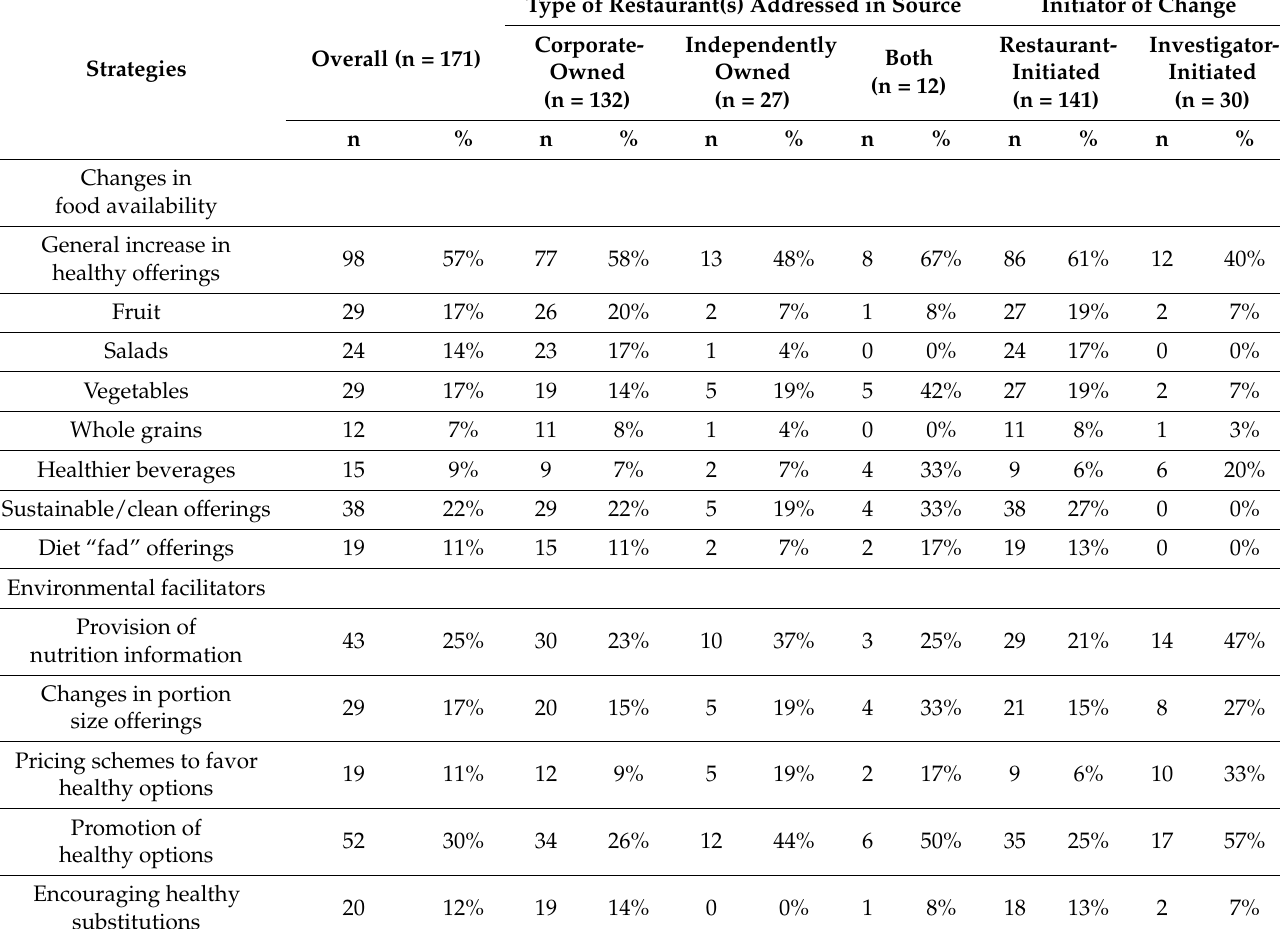
Table 1. Consumer-facing strategies reported, overall and by type of restaurant addressed in source and initiator (n = 171).